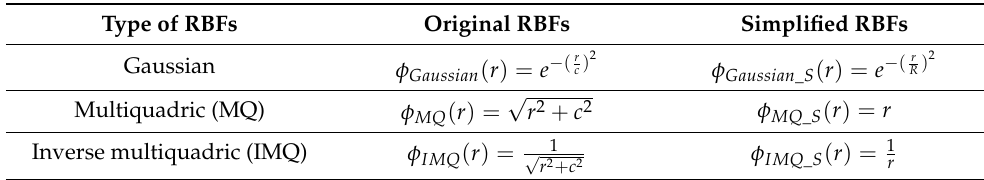
( r ) = e − ( r R ) 2 ( r ) = e − ( r c ) 2 φ Gaussian _ S Gaussian √ r 2 + c 2 φ MQ _ S ( r ) = r r 2 + c